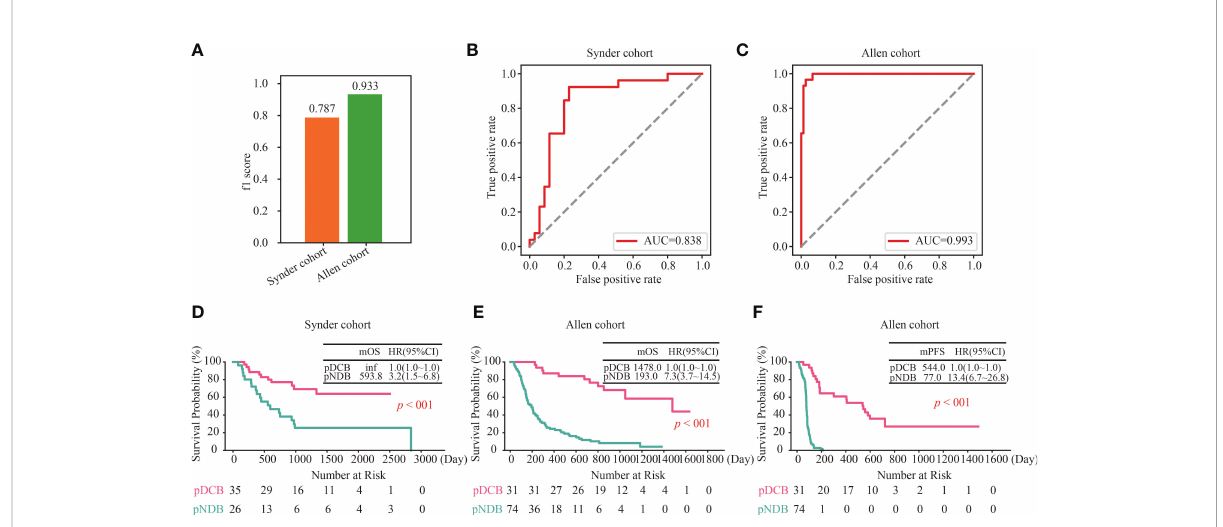
FIGURE 3 Validation of the DCB model in other independent cohorts. (A) f1 score of the DCB model in the Snyder and Allen cohorts. (B, C) ROC curves for the DCB model in the Snyder (B) and Allen (C) cohorts. (D) Kaplan – Meier curves of OS comparing pDCB with pNDB from the DCB model in Snyder cohort. (E, F) Kaplan – Meier curves of OS (D) and PFS (E) comparing pDCB with pNDB from the DCB model in Allen